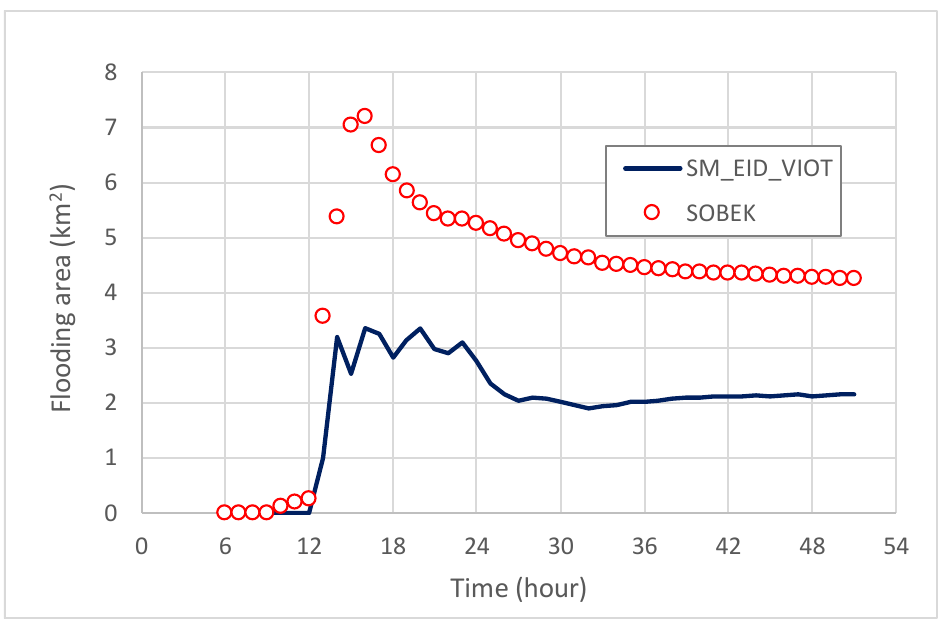
Figure 22. Comparison of flooding-area hydrograph quantified estimated via the proposed SM_EID_VIOT model with the results from the SOBEK as validated data. Table 7. Statistics of the performance indices of the estimated flooding region.